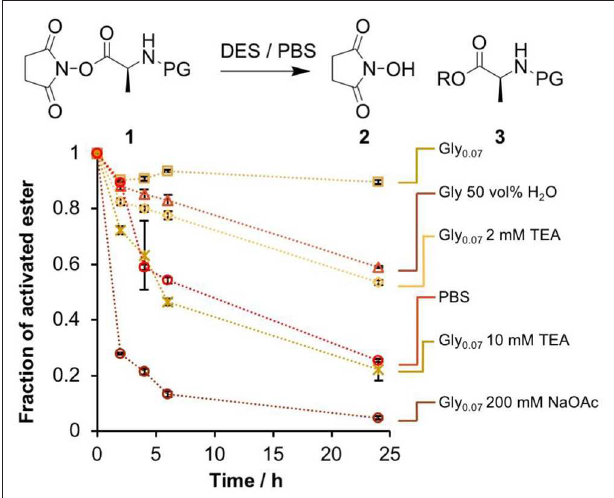
FIGURE 1 | Comparison of the stability of the NHS ester 1 in several glycholine and aqueous PBS solutions. The fraction of 1 remaining at set time points was determined by 1 H-NMR spectroscopy by extraction into an immiscible deuterated solvent. Error bars correspond to the standard deviation over multiple integration